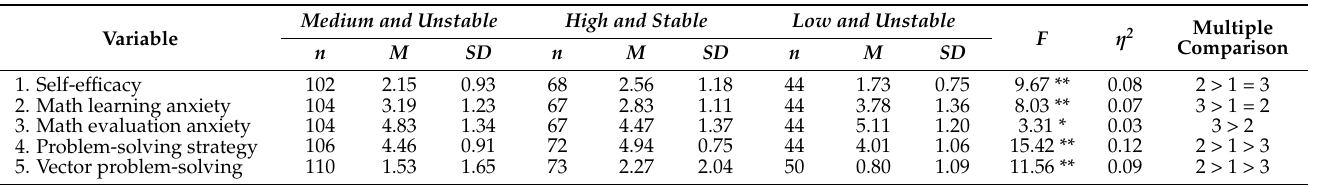
Table 7. The differences in self-efficacy, math anxiety, and vector problem-solving between different clusters and the results of multiple comparisons by using the Holm